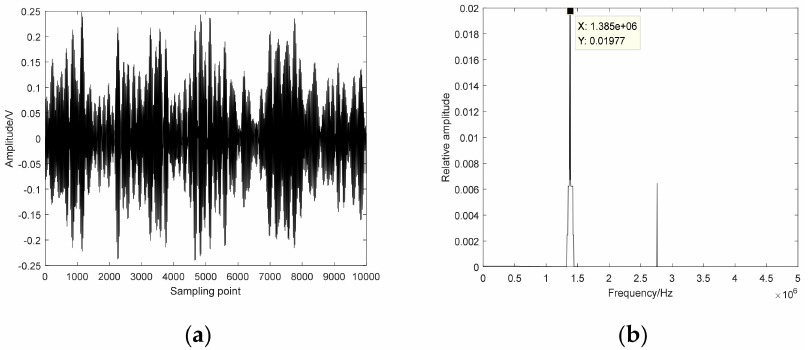
Figure 7. The time–domain diagram and frequency spectrum of HIFU echo signal. ( a ) Time–domain diagram; ( b ) Frequency spectrum.